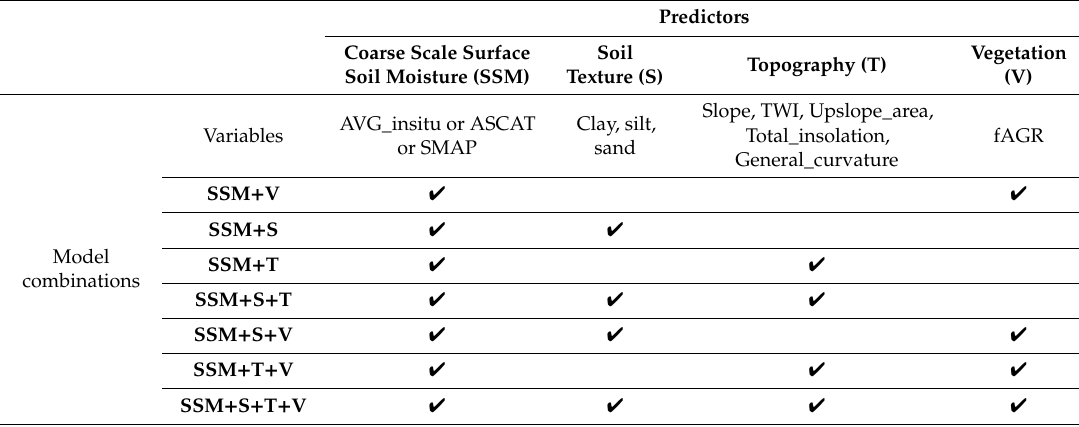
Table 1. Summary of model combinations tested in this